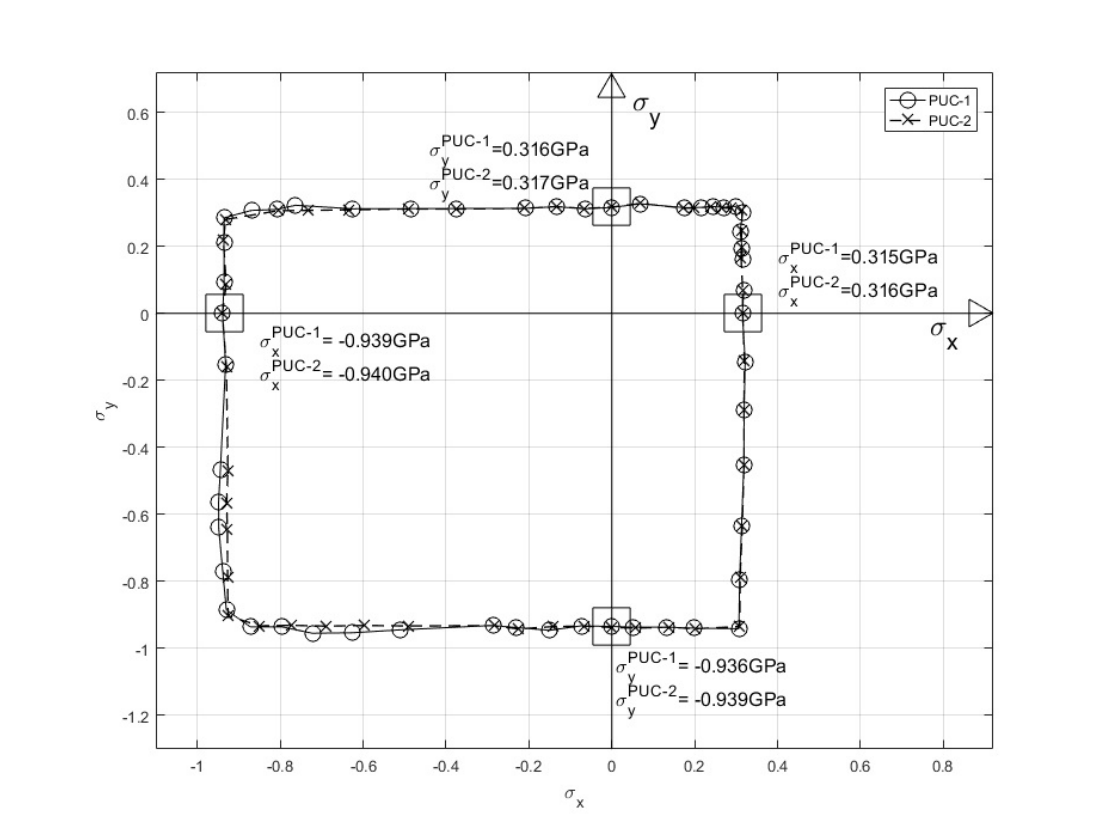
Figure 10. Failure envelope for biaxial loading in the transverse